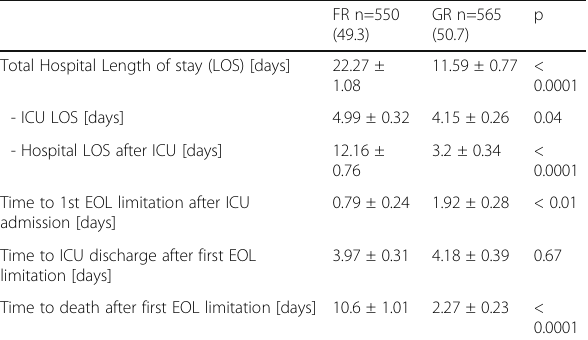
Table 1 (abstract 000734). Comparison between FR and GR